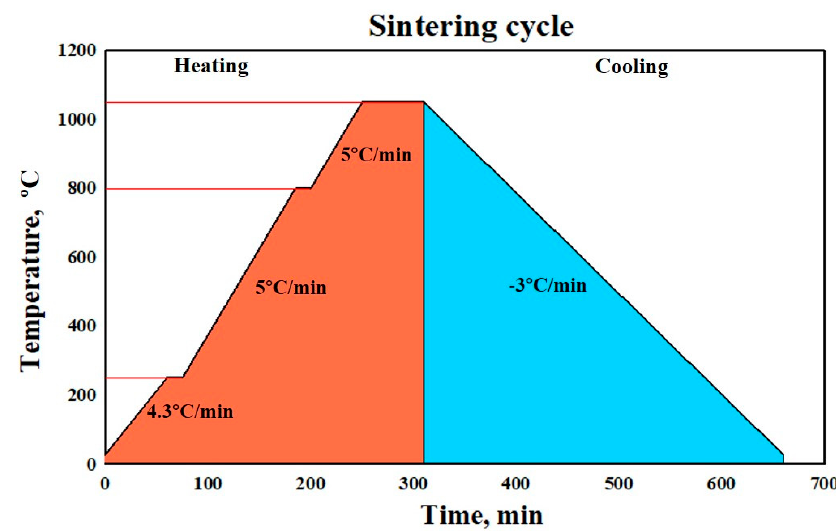
Figure 1. Sintering cycle used for all